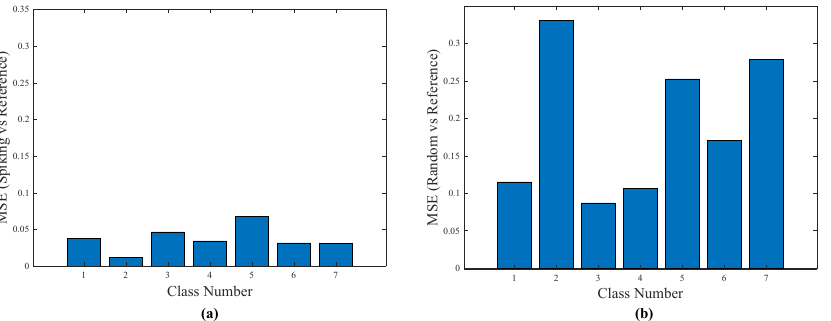
Figure 15. MSE values. ( a ) MSE-1: Spiking versus Reference. ( b ) MSE-2: Random versus Reference.